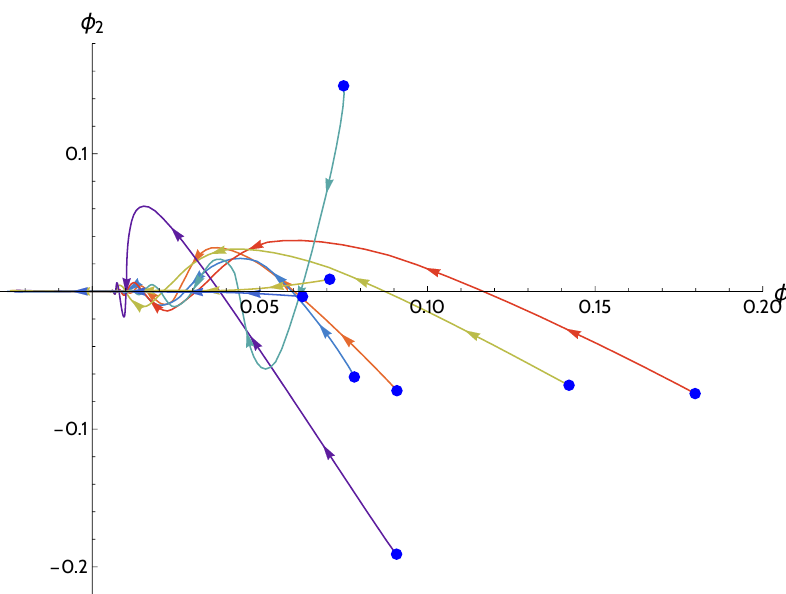
Figure 12. Showcase of several in(cid:13)ationary trajectories from di(cid:11)erent tunnelings to the central in(cid:13)ection point. Each exit point is marked by a blue